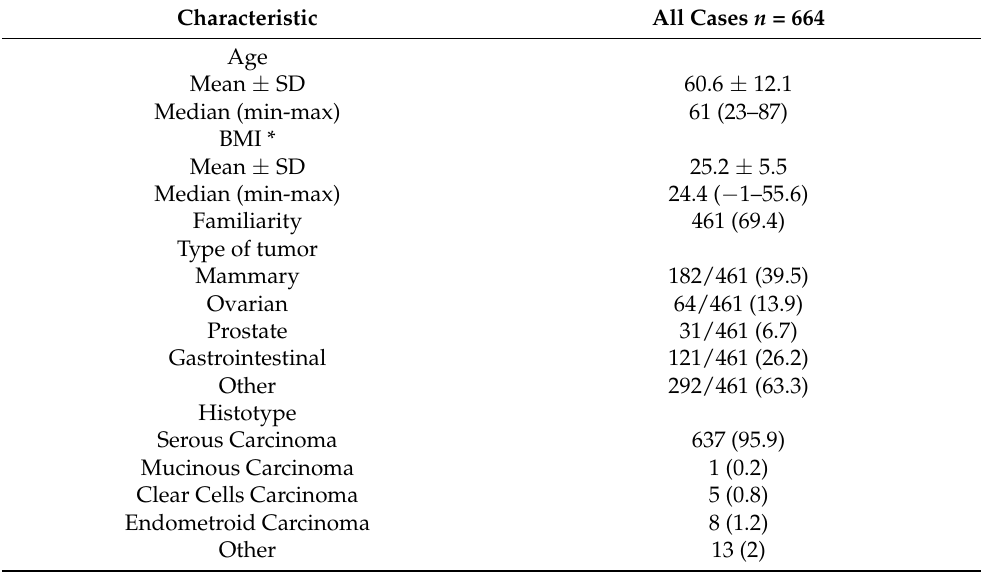
Table 1. Clinical, pathological and surgical characteristics of the study